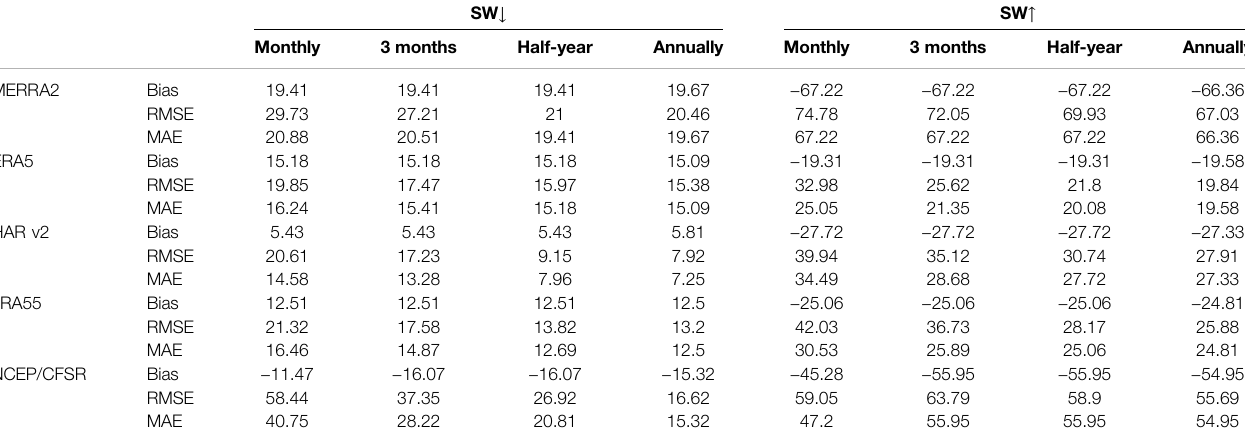
TABLE 4 | Evaluation of monthly and annual scales of shortwave radiation from fi ve sets of reanalysis